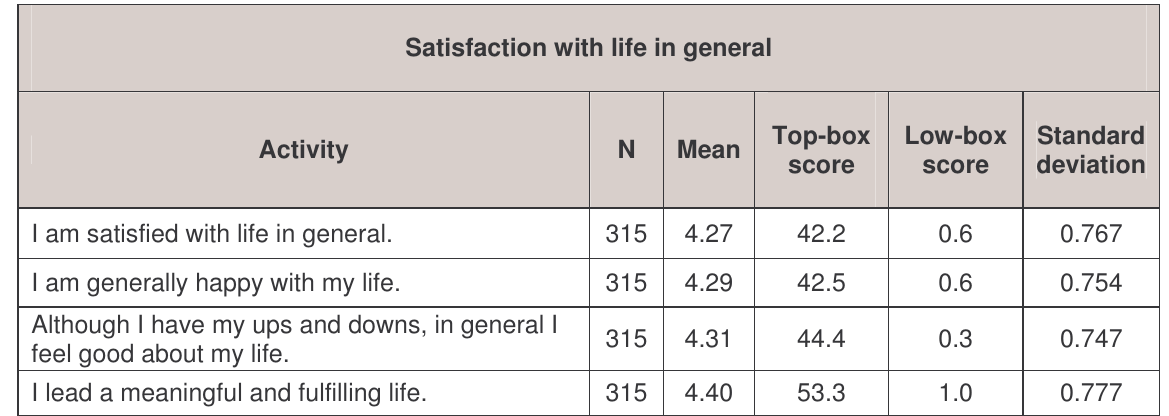
Table 6: Satisfaction with life in general